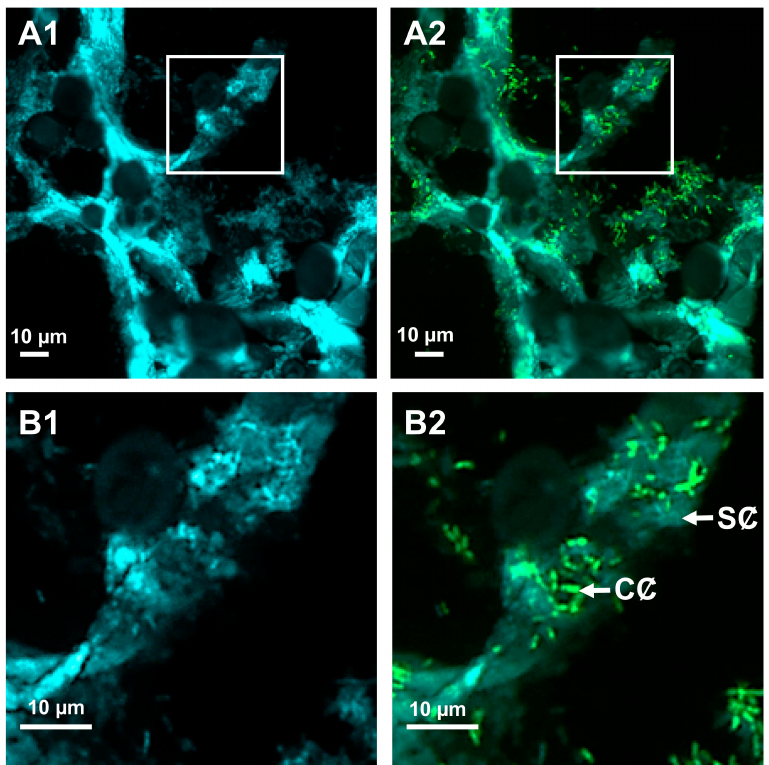
Figure 3. Simultaneous observation of the location and quorum-sensing communication of Pectobac- terium atrosepticum during potato tuber soft-rot. Tubers were wounded and inoculated axenically with the P. atrosepticum CFBP6276 dual-colored strain (see Table 1): the constitutively produced cyan fluorescent protein served as a cell tag (blue fluorescing cells), whereas reporter fusion based on the green fluorescent protein (GFP) enabled the simultaneous recording of the production and presence of N -acyl-homoserine lactone (AHL) signaling molecules (green fluorescing cells). Confocal microscopy observations of the bottom surface of the tuber wound were achieved at two days post-inoculation with an ultrathin cross-section. Images were combined in the blue and red channels ( A1 , B1 ), supplemented with the green channel ( A2 , B2 ). In these conditions, slight blue ( A1 , B1 ) or celadon ( A2 , B2 ) autofluorescence revealed the cell wall structure of the pith, as well as translucent parenchyma cells containing opaque and oval amyloplasts. Close-ups (delineated by squares) of clustered and embedded pectobacterial cells in ( A1 , A2 ) are shown in ( B1 , B2 ), respectively.